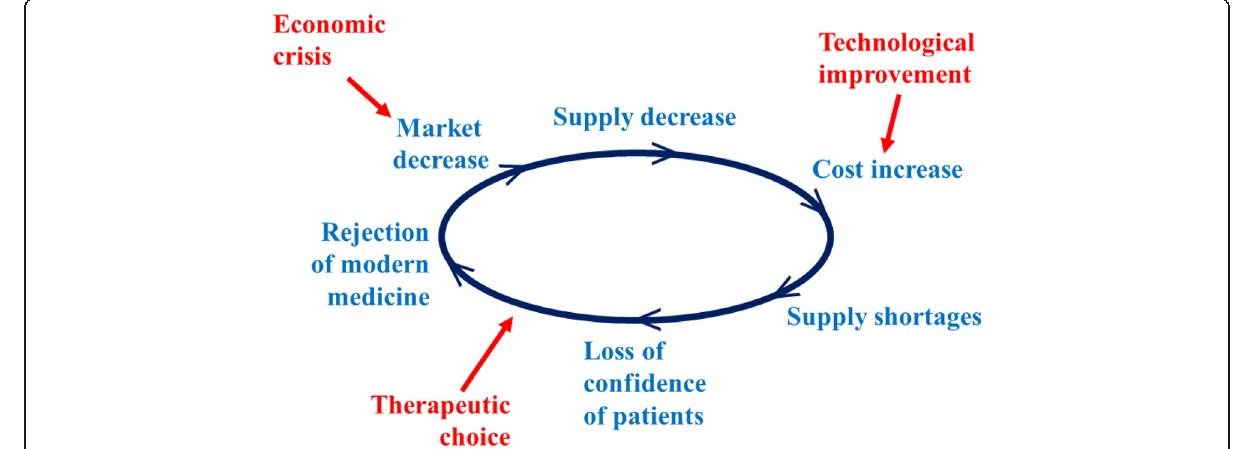
Fig. 3 Vicious circle of distribution of antivenoms showing the reduction of accessibility (modified from